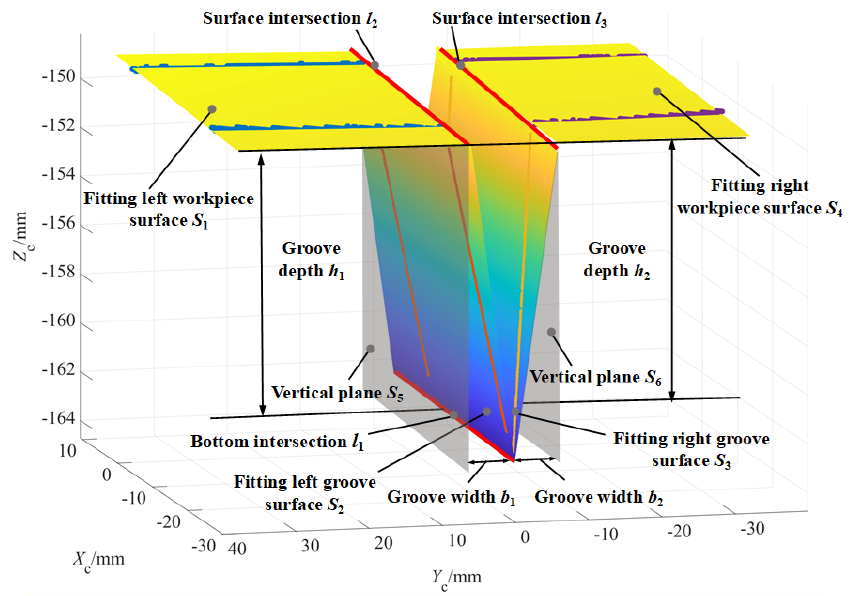
Figure 8. Three-dimensional reconstruction of welding groove surfaces and its adjacent workpiece surfaces of planar workpiece based on plane